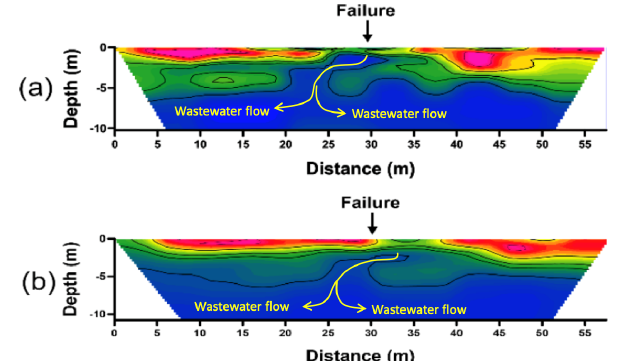
Figure 5. Interpreted lines of wastewater flow detected with ERT using an electrode spacing of 2.5m, and electrode configurations of (a) dipole-dipole, and (b)